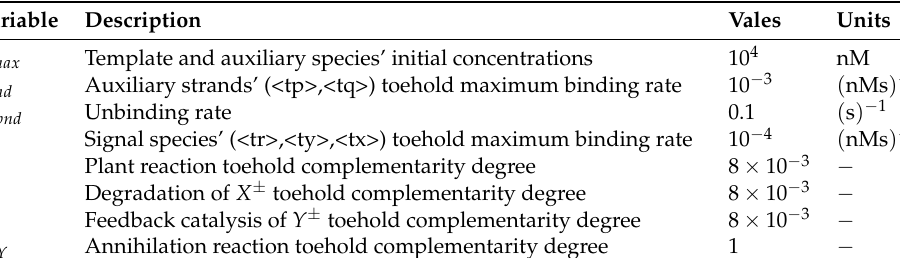
Table 2. The state feedback control circuit’s parametrisation for the Visual DSD simulation.